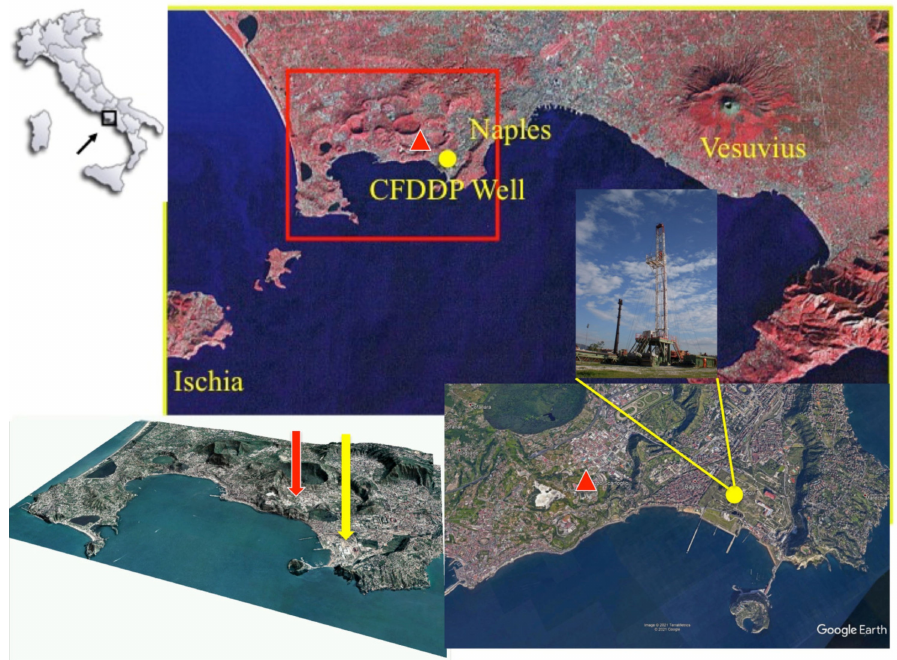
Figure 1. An overview of the Neapolitan volcanoes from a satellite image, with Campi Flegrei caldera evidenced in different points of view. The site of the Bagnoli 1 borehole CFDDP (yellow circle) and the Agnano geothermal well (red triangle) are also shown on the